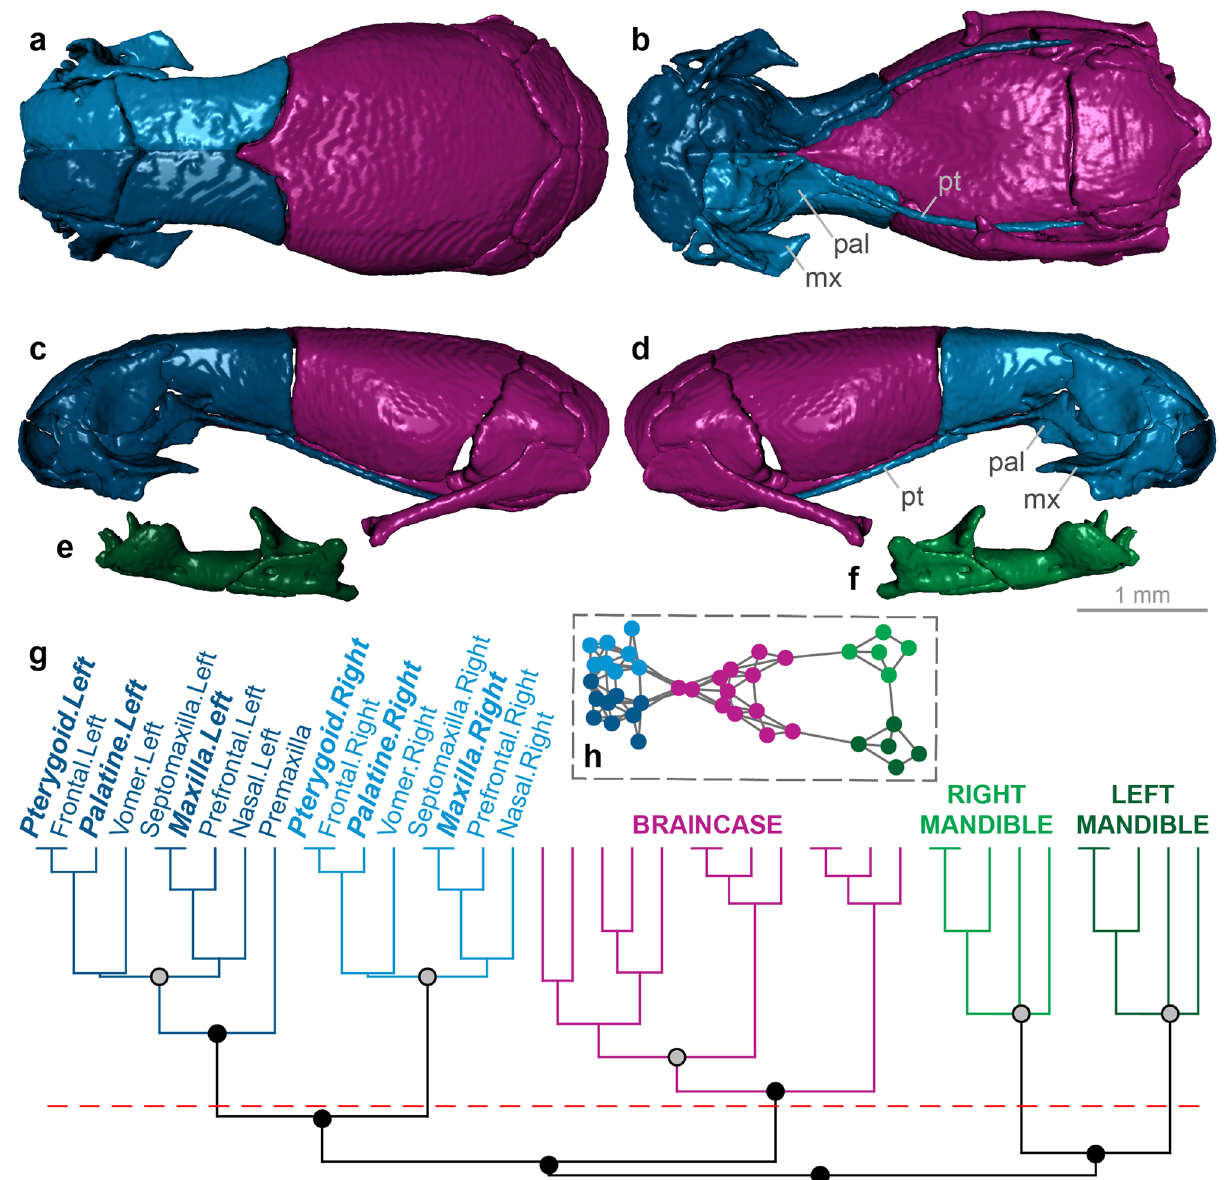
Figure 4. Skull modularity of leptotyphlopid scolecophidians. Leptotyphlopids exhibit a highly consistent pattern of modularity, in which the palatomaxillary elements (in italicized boldface) are thoroughly integrated with the snout. ( a–f ) Typical pattern of leptotyphlopid skull modularity, illustrated using Epictia albifrons (MCZ R-2885) in ( a ) dorsal, ( b ) ventral, ( c ) left lateral, and ( d ) right lateral views of the skull, and ( e ) left lateral and ( f ) right lateral views of the mandible. ( g ) Network dendrogram of Epictia , reflecting this general leptotyphlopid network structure. Q-modules are indicated by Q max (represented by the red dotted line). S-modules are indicated by black (p < 0.001), grey (0.001 ≤ p < 0.01), or white (0.01 ≤ p < 0.05) circles. ( h ) Network representation of the skull of Epictia (see Supplementary Fig. S58 for labelled version). mx maxilla, pal palatine, pt pterygoid. Dendrogram and network generated in R [v.4.0.3] 122 and RStudio [v.1.3.1093] 123 (see “Methods” section); specimen visualized in Dragonfly [v.4.1] 114 . MCZ scan data used by permission of the Museum of Comparative Zoology, Harvard (Fig. 2; Supplementary Figs. S1–S13), particularly regarding the presence of the ectopterygoid and the inclu- sion of the prefrontal. When not grouped with the ectopterygoid and maxilla, the prefrontal, palatine, and/or pterygoid are recovered alongside the snout elements (Supplementary Figs. S14, S18, S19). This overall pattern of skull modularity is again quite consistent across anomalepidids, with the only minor exceptions being the formation of a separate vomer-palatine module in Anomalepis (Supplementary Fig. S14), the inclusion of the vomer in the palatomaxillary module in Helminthophis (Supplementary Fig. S15), and the presence of separate left